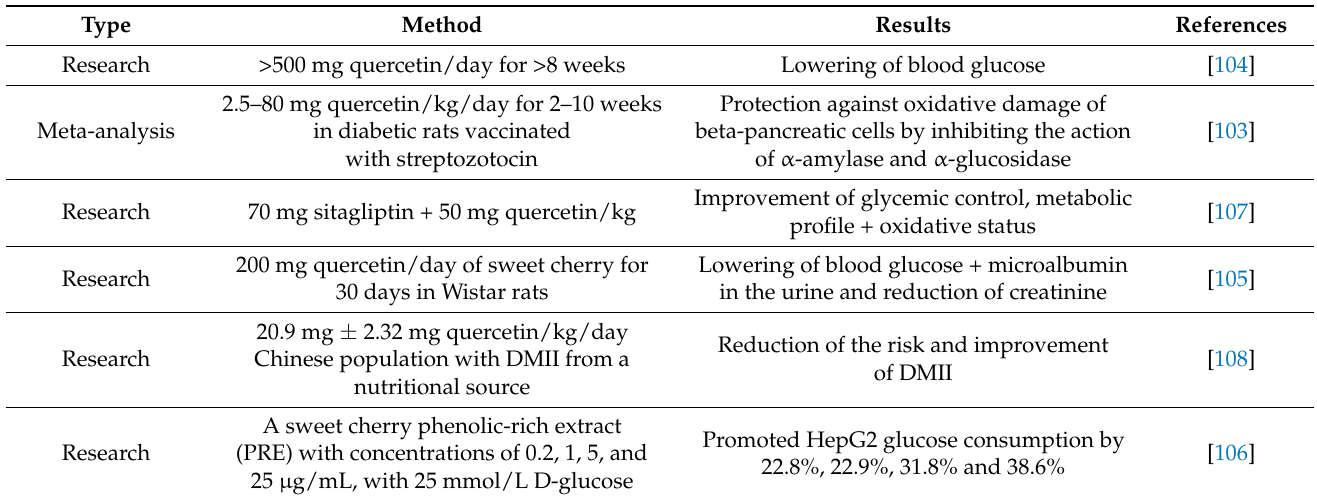
Table 2. Research and meta-analysis of the effect of quercetin on diabetes